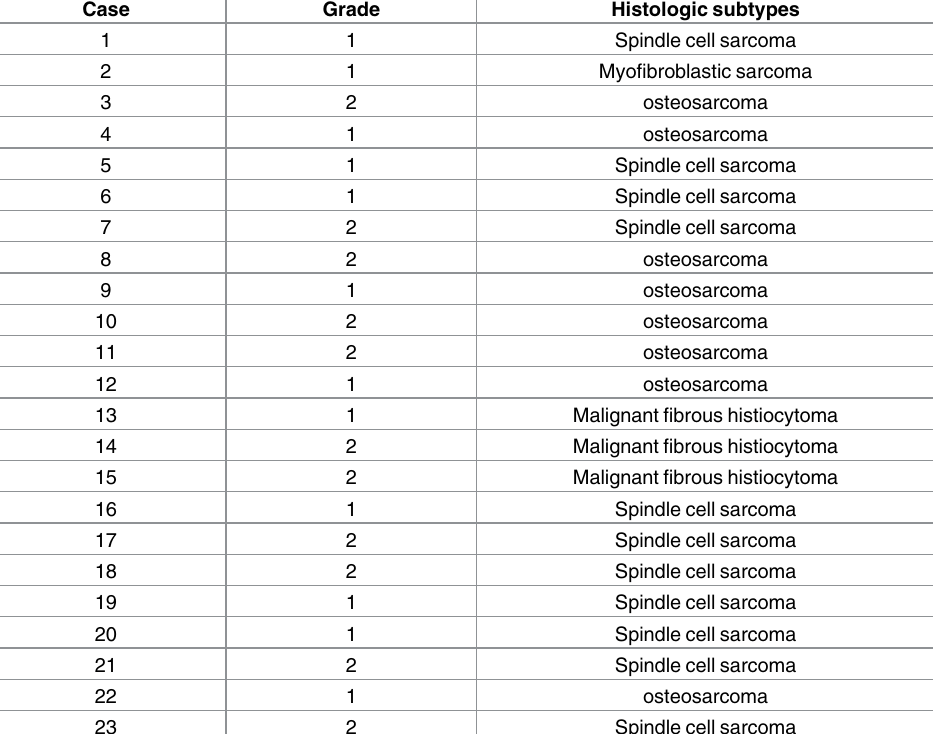
Table 3. The histological grade of cartilage component and subtypes of dedifferentiation in 23 patients.